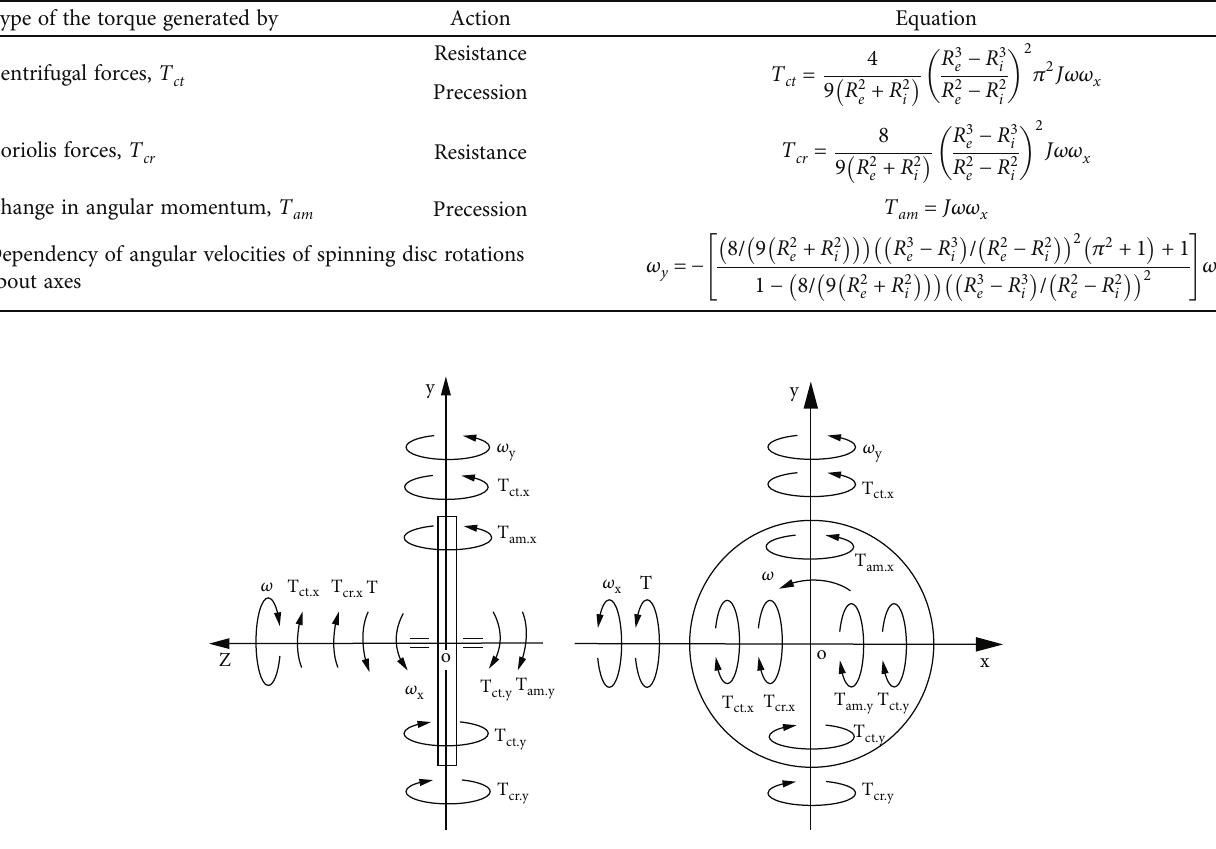
Figure 4: External and inertial torques acting around axes on the spinning object.